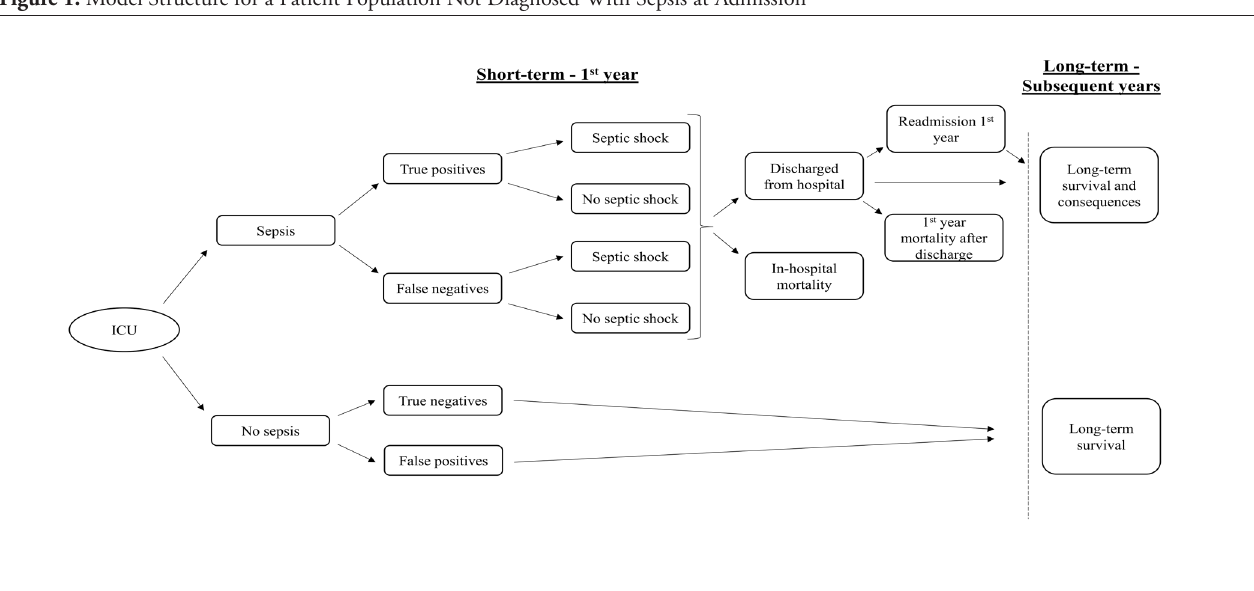
Abbreviation: ICU, intensive care